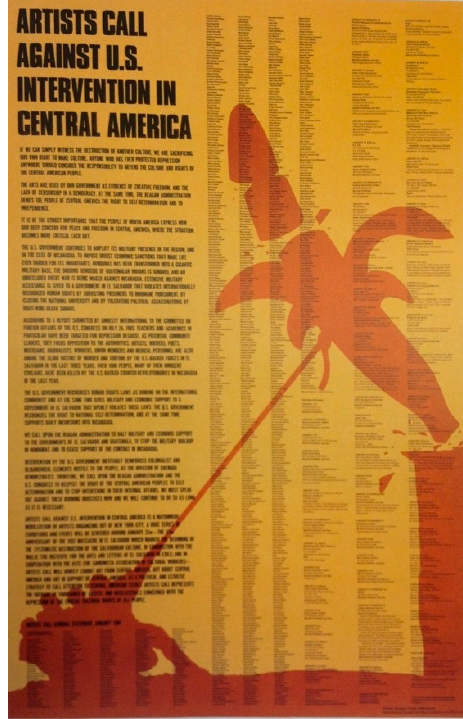
Figure 9. Claes Oldenburg, poster for Artists Call Against U.S. Intervention in Central America, 1984, offset printed, 37 × 24 inches. Artists Call Against US Intervention in Central America, miscellaneous uncatalogued material, MoMA Library, used by permission.